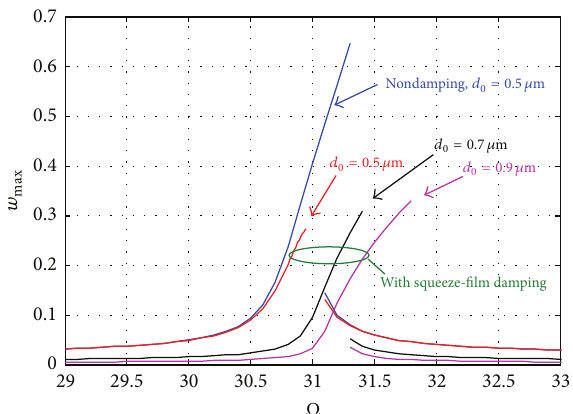
Figure 15: Frequency response curve of different initial gaps under squeeze-film